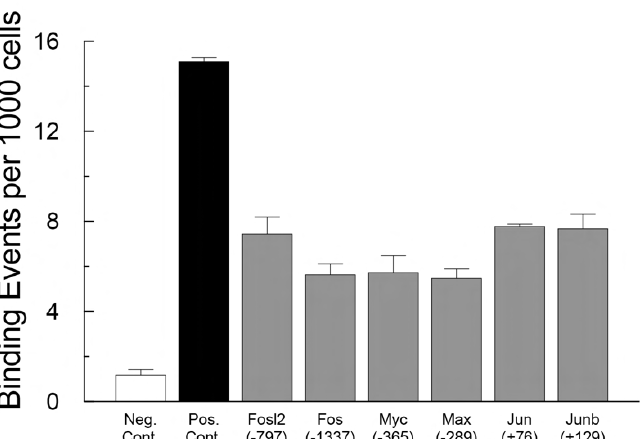
Figure 6. Specific binding of PGRMC1-Flag (i.e., >5 binding sites/1000 cells) to DNA segments located at or near the promoter region of several “immediate-early” genes associated with entry into the cell cycle. The gene and the distance from the start site that interacts with PGRMC1-Flag is shown on the X-axis. Analysis was completed using SIGCs and conducted by ActivMotif as outlined in their ChIP-seq (https://www.activemotif.com/catalog/819/chip-sequencing-service (accessed on 30 April 2022) and ChIP-qPCR services (https://www.activemotif.com/catalog/833/chip-qpcr-servicesaccessed on 30 April 2022).